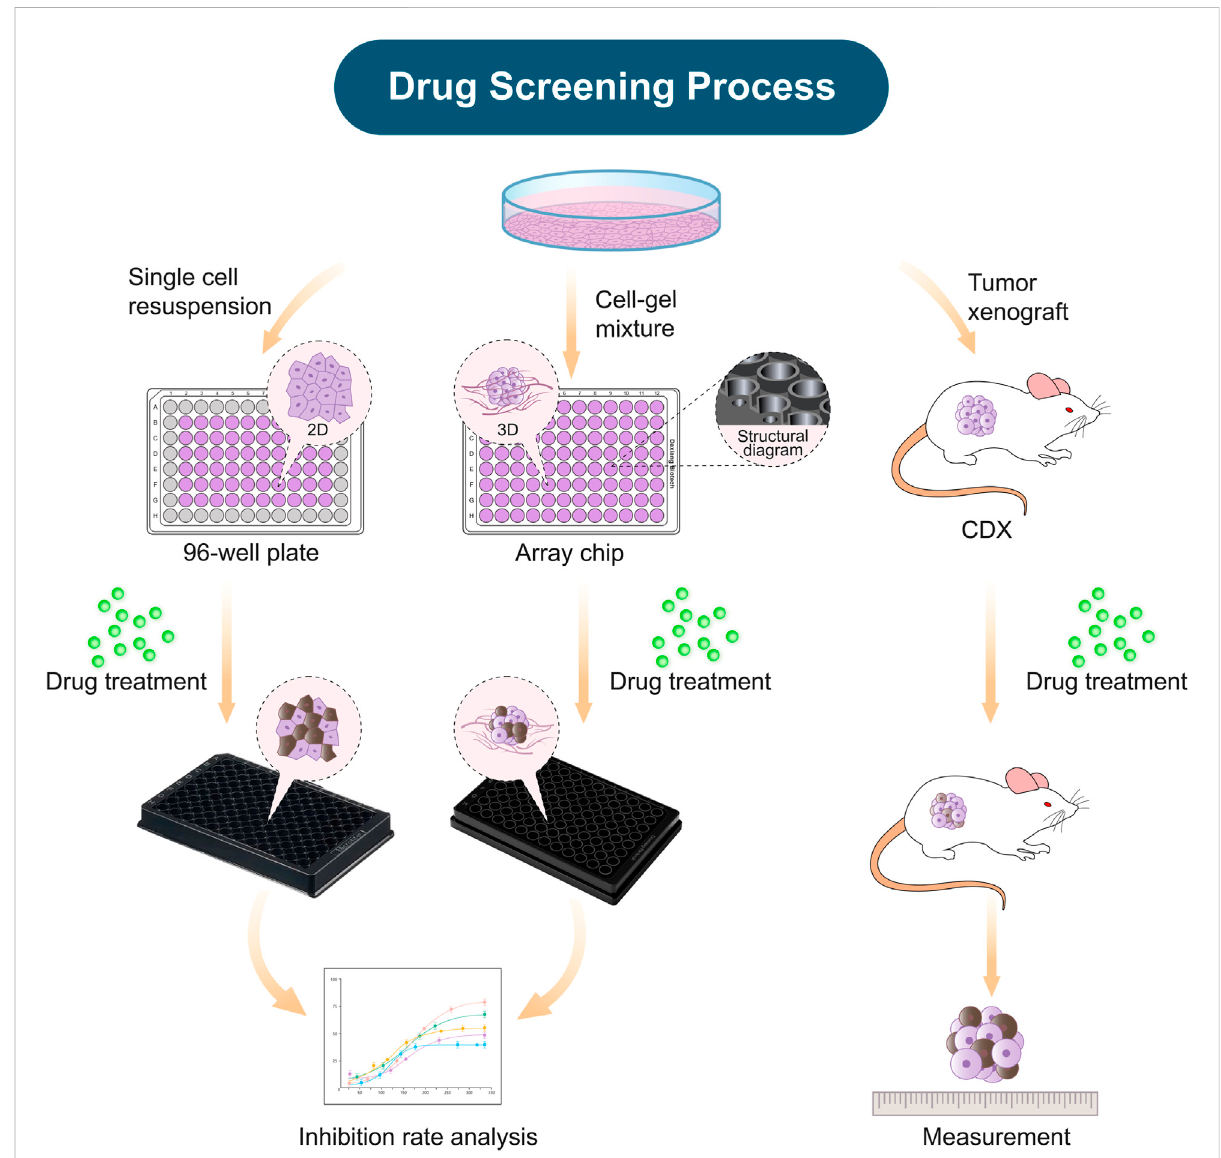
FIGURE 1 Schematic diagram demonstrating the construction of in vitro and xenograft tumor models for drug ef fi cacy evaluation. The establishment of the tumor models, including the 2D model on the 96-well plate, the 3D model on the array chip, and the cell-derived xenograft model (CDX). All these tumor models were applied for evaluation of anticancer drug ef fi